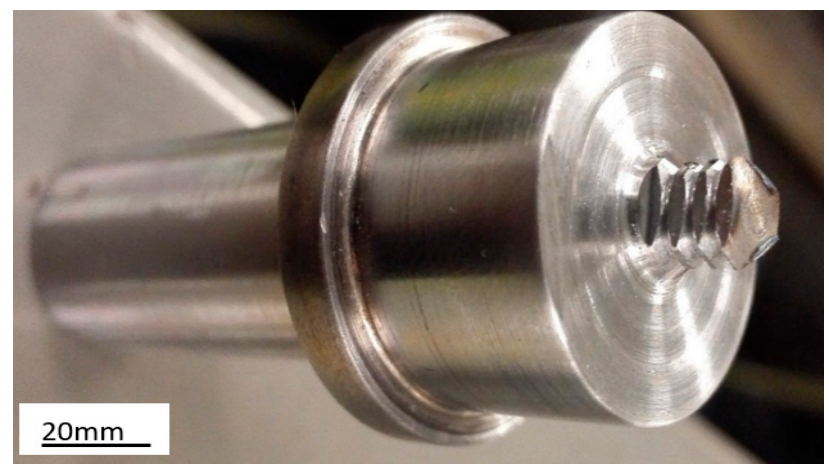
Figure 3. Friction stir welding tool.